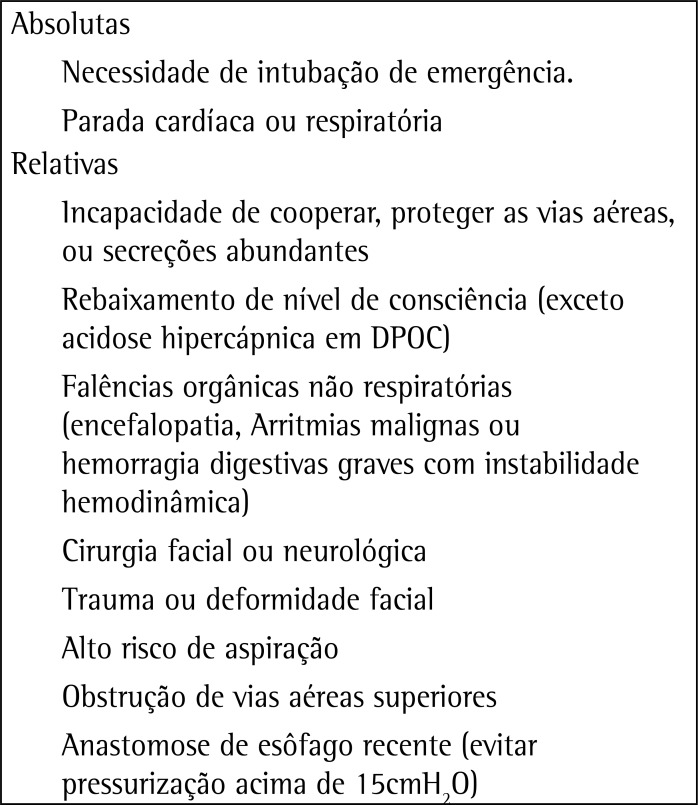
Contraindicações a ventilação não invasiva DPOC - doença pulmonar
obstrutiva crônica.